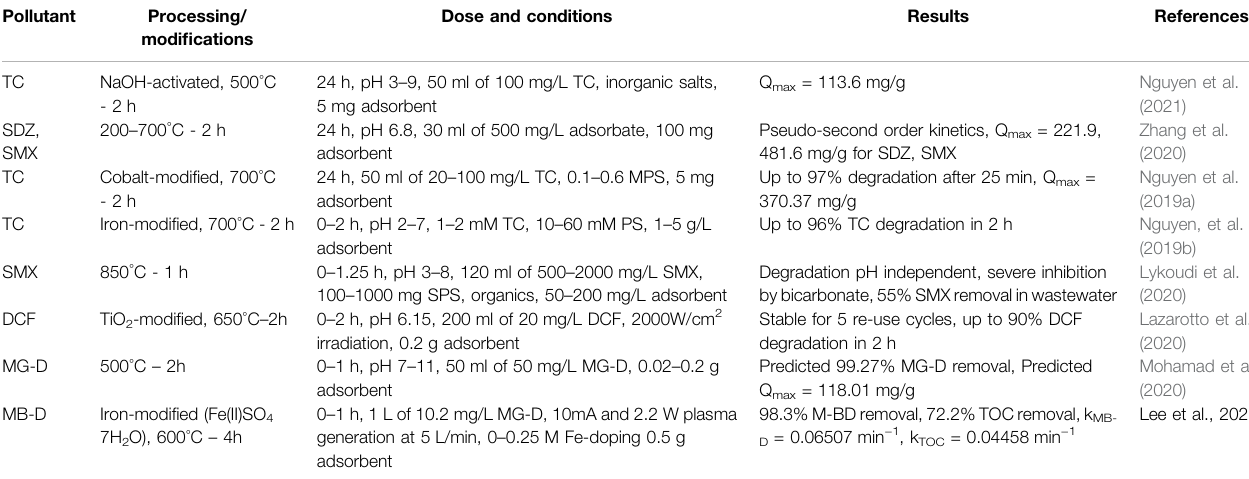
TABLE 7 | Recent studies on SCG derived biochar adsorption of pharmaceuticals, antibiotics, and